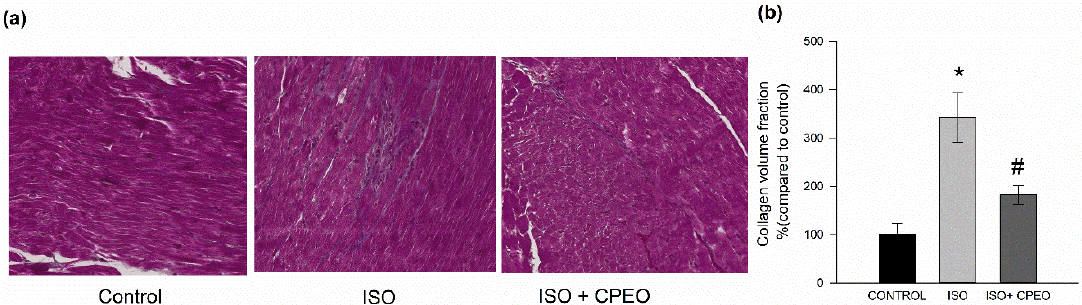
Figure 4. Effect of Cymbopogon proximus essential oil (CPEO) and/or isoproterenol (ISO) on myocardial fibrosis. Male albino rats were injected intraperitoneally daily with vehicle, CPEO (800 µL/kg/d), ISO (5 mg/kg), or CPEO (800 µL/kg/d) plus ISO (5 mg/kg). Oil administration was started 4 d prior to ISO administration and continued concurrently thereafter for an additional 3 d. Histological analysis and pathological changes in cardiac tissue. ( a ) Representative Masson’s trichrome staining of left ventricles of control group rats and rats treated with ISO+CPEO or ISO alone. ( b ) Quantitative analysis of myocardial collagen volume fraction (CVF) in the left ventricles of rats of the experimental and control groups. The results are presented as the means of four independent experiments ± SEM. * p < 0.05 compared to control, # p < 0.05 compared to ISO-treated rats.